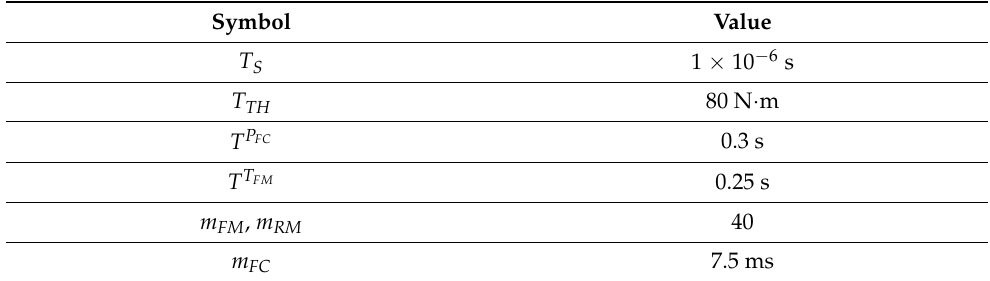
Table 3. Different simulation parameters.